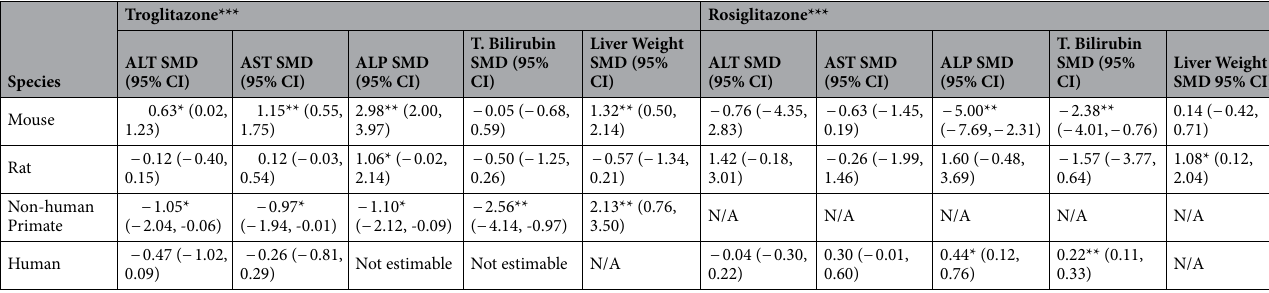
Table 2. Summary of forest plot results of five liver-related outcomes. * P ≤ 0.05; ** P ≤ 0.005. SMD standard mean difference; Not estimable = too few studies reporting endpoint to estimate SMD; N/A = no studies reporting endpoint; ***See Table 1 for species-specific dose information.